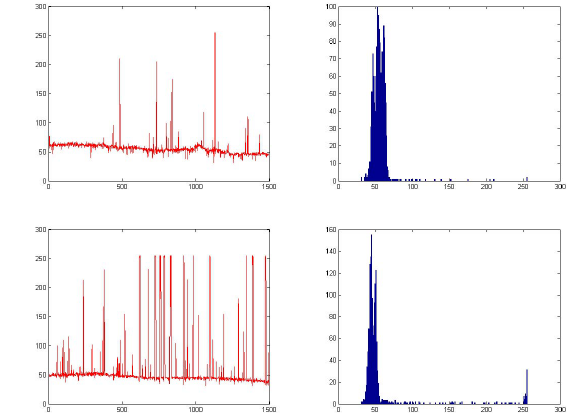
Figure 3: Top: the left graph is the temporal profile of a selected pixel gray level as a function of time, that is, the gray level (y- axis) is given as a function of the image number in the image sequences (x-axis). The top right graph shows the histogram of gray levels of the same profile. Bottom: similarly for another